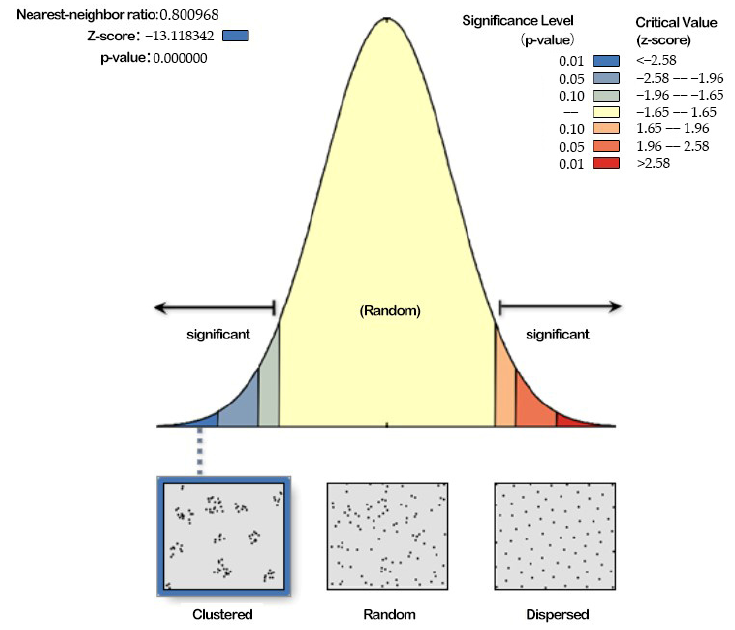
Figure 7. Average nearest neighbor analysis results of NPAs in Guangdong